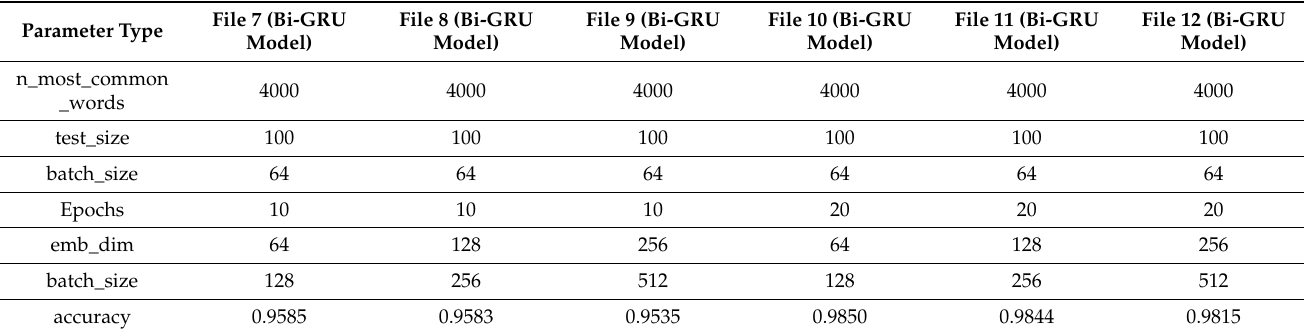
Table 5. Chatbot program test results (Files 7 to 12).